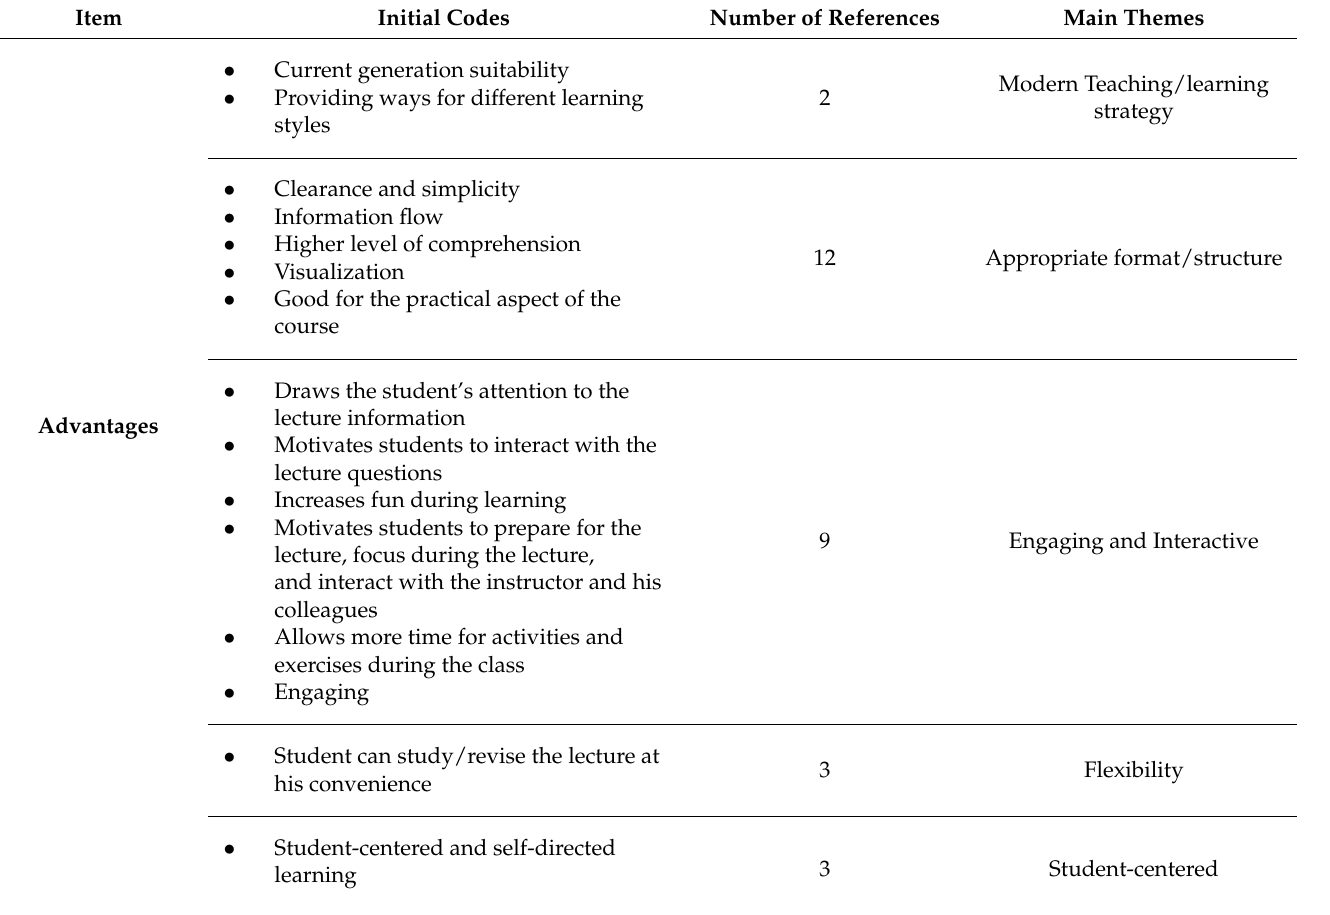
Table 8. Advantages and disadvantages of interactive flipped e-learning activity (iFEEL) from faculty points of